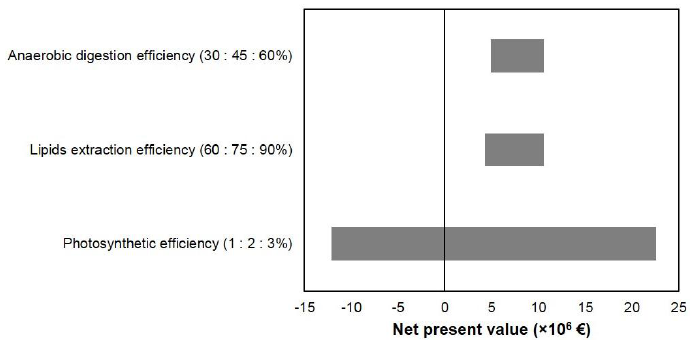
Figure 5. Sensitivity analysis of the process considering the different studied scenarios.